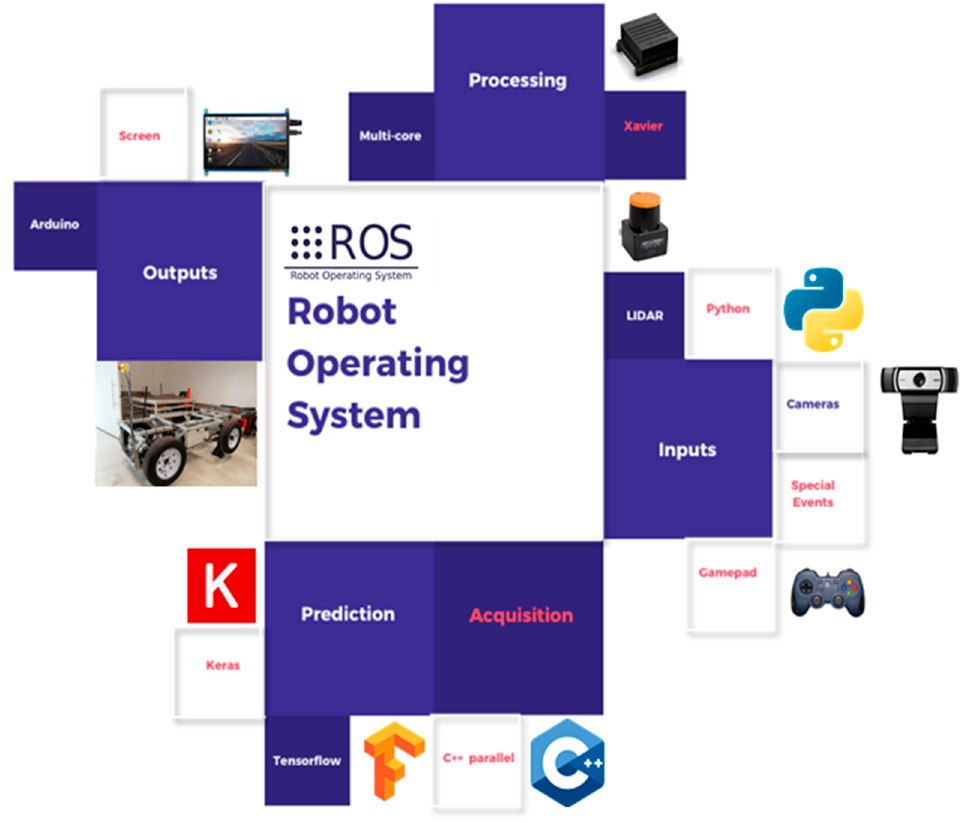
Figure 7. Robot Operating System (ROS) integration diagram.